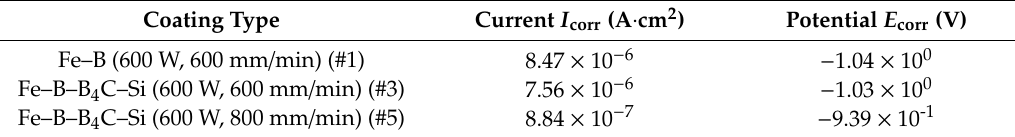
Figure 8. Potentiodynamic curves for Fe–B and Fe–B–B 4 C–Si composite coatings produced by the laser cladding method (specimen numbers in accordance with Table 2). Table 4. Corrosion current and corrosion potential of C45 steel specimens with Fe–B and Fe–B–B 4 C–Si composite coatings produced using laser cladding method.